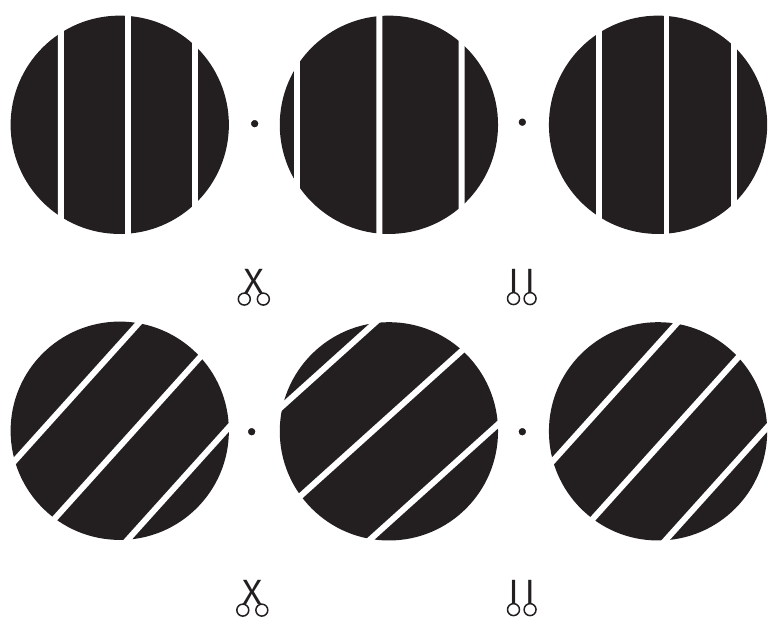
Figure 4. Stereoscopic illustration of the vertical line stimulus with horizontal disparity in the top row (Exp. 1) and an oblique line stimulus with horizontal and orientation disparity in the bottom row (Exp. 2). Cross-fusing the two dots to the left and right of the middle aperture or fusing the middle and right aperture (uncrossed fusion) gives an impression of the 3D orientation of the line stimulus at a “far”, “centre”, and ”near” position. In each trial the line stimulus moved back and forth between the near and far inflection position, suggesting a motion direction in